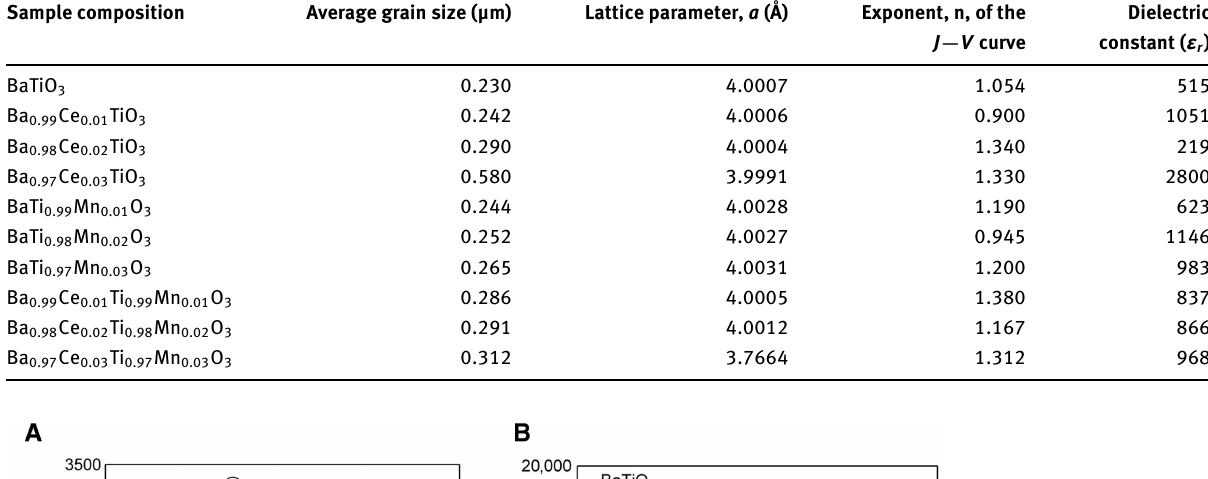
Table 1: Values of average grain size, lattice parameter, and exponent, n, in J ∝ V n and dielectric constant of the samples for different compositions.